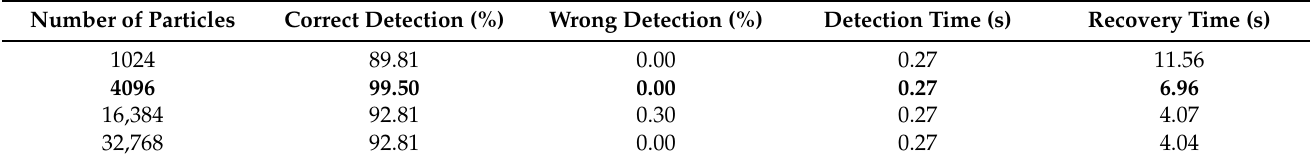
Table 4. Sensitivity analysis on ∆